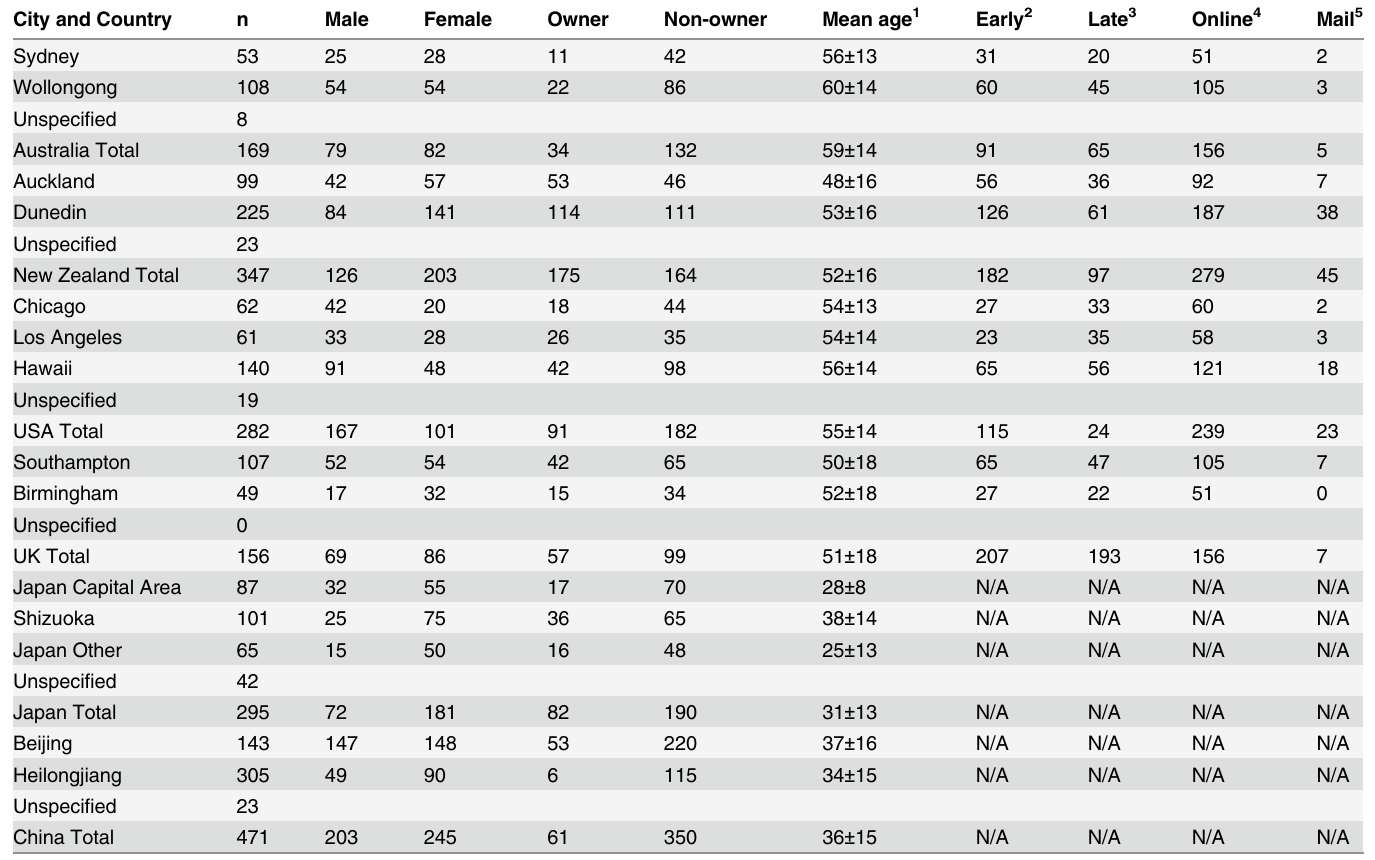
Table 2. Characteristics of respondents in each